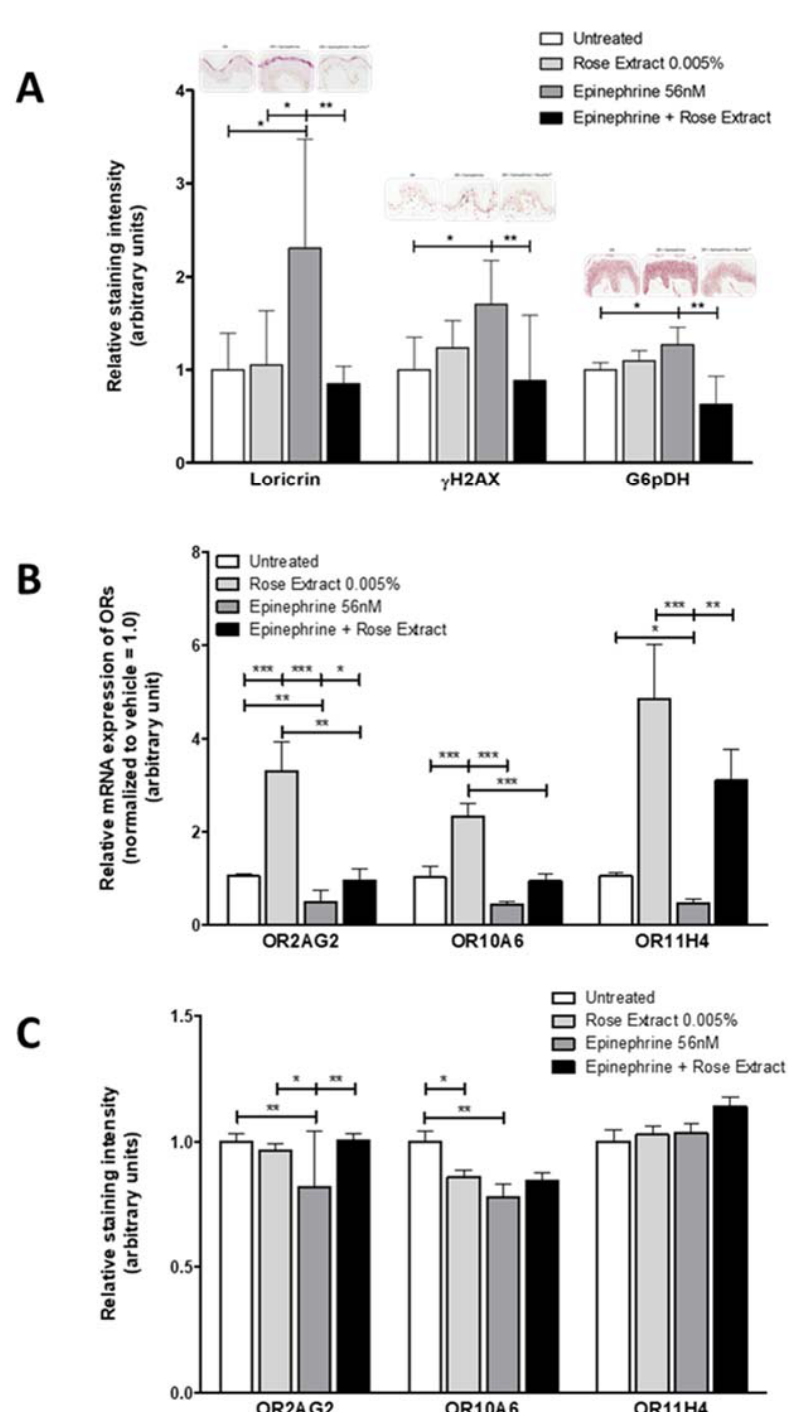
Figure 3. Effect of rose extract (5 × 10 − 3 %) on epinephrine–induced (56 nM) stress markers and OR expression in skin explants. ( A ) Epinephrine-induced stress for 9 days significantly stimulates the expression of loricrin, γ H2AX, and G6pDH protein expression in skin explants, whereas co-treatment with rose extract prevents these stress manifestations. ( B ) The expression levels of mRNA encoding for OR2AG2 and OR10A6 significantly decrease with epinephrine treatment (**OR2AG2, *OR11H4), while results for OR10A6 did not reach statistical significance. Co-treatment with rose extract significantly inhibits the stress-induced decrease in mRNA expression levels of OR2AG2 and OR11H4, while results for OR10A6 did not reach statistical significance. ( C ) The protein expression of OR11H4 remains unchanged by epinephrine-induced stress, whereas expression of OR2AG2 and OR10A6 (** OR2AG2, ** OR10A6) is significantly reduced. Co-treatment with rose extract significantly inhibits the stress-induced decrease expression levels of OR2AG2. Data are presented as mean ± SEM values. Statistical analysis was performed using ANOVA (Kruskall–Wallis, * p ≤ 0.05, ** p ≤ 0.01, and *** p ≤ 0.001) to compare each